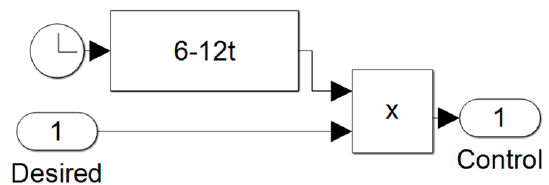
Figure A5. Open-loop optimal controller topology.